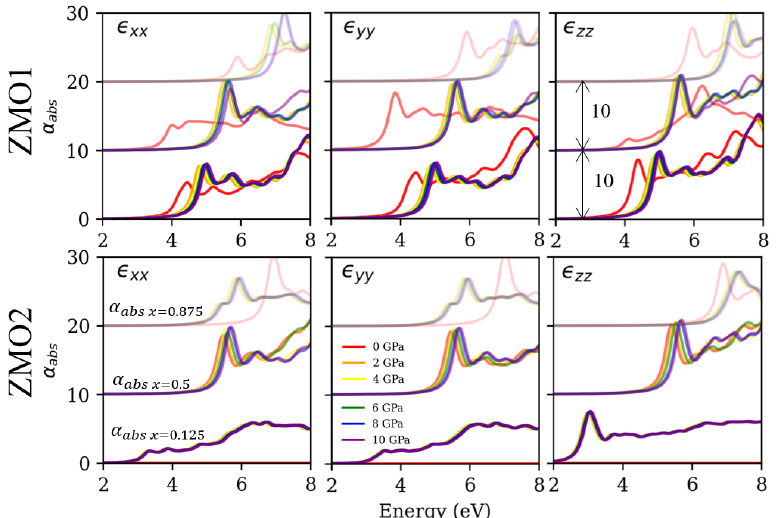
Figure 7. The frequency-dependent absorption coefficient of wurtzite (WZ) Zn 1 − x Mg x O based on the BSE (cid:101) ( ω ) for the WZ ZMO1 (upper panel) and WZ ZMO2 (bottom panel). The WZ ZMO1 and WZ ZMO2 correspond to the illustrations in Figure 1. The spectrum with different concentrations of 0.125, 0.5 and 0.875 is individually adjusted by adding the values of 0, 10 and 20 to the y axis. The symbols, colors and legends of this figure are identical to the descriptions in Figure